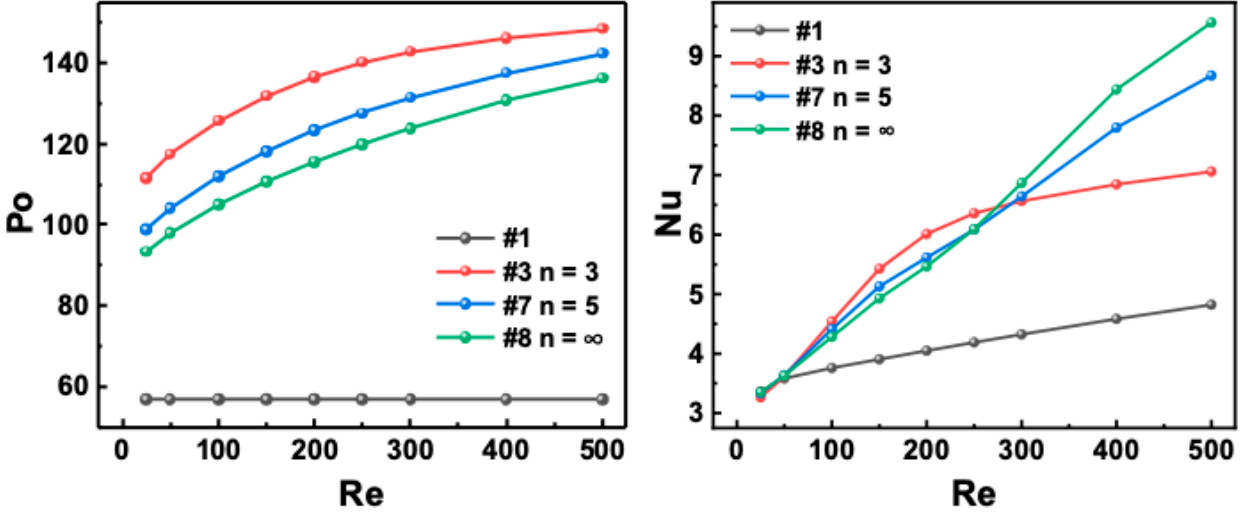
Figure 9. Po versus Re with different fin